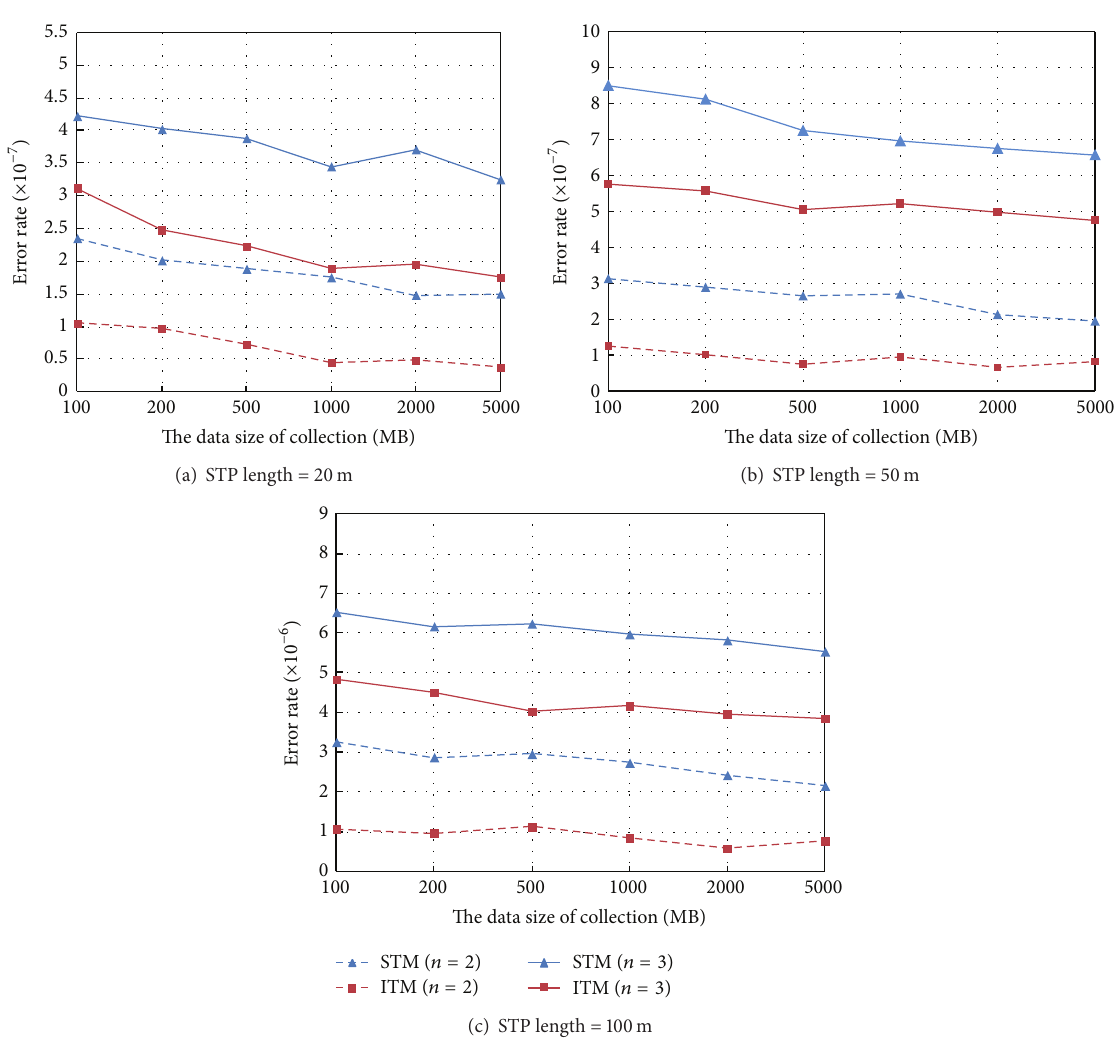
Figure 8: The relationship between the data size and error rate when twisted length is 20 m, 50 m, or 100m.